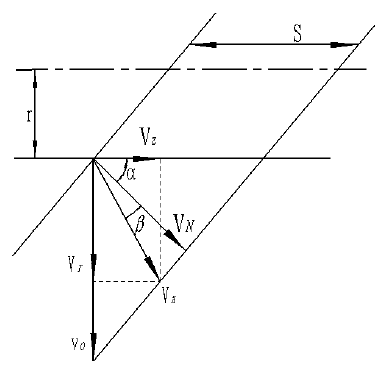
Figure 5. Fertilizer speed decomposition diagram. S —pitch, mm; r —distance between the particles on the spiral surface and the spiral axis, mm; V N —implicated velocity, m/s; V a —absolute velocity, m/s; Vr —circumferential directional fractional velocity, m/s; V z —axial directional fractional velocity, m/s; V 0 —initial velocity, m/s; α -spiral lift angle of the spiral blade, ◦ ; β —external friction angle of the fertilizer particles, ◦